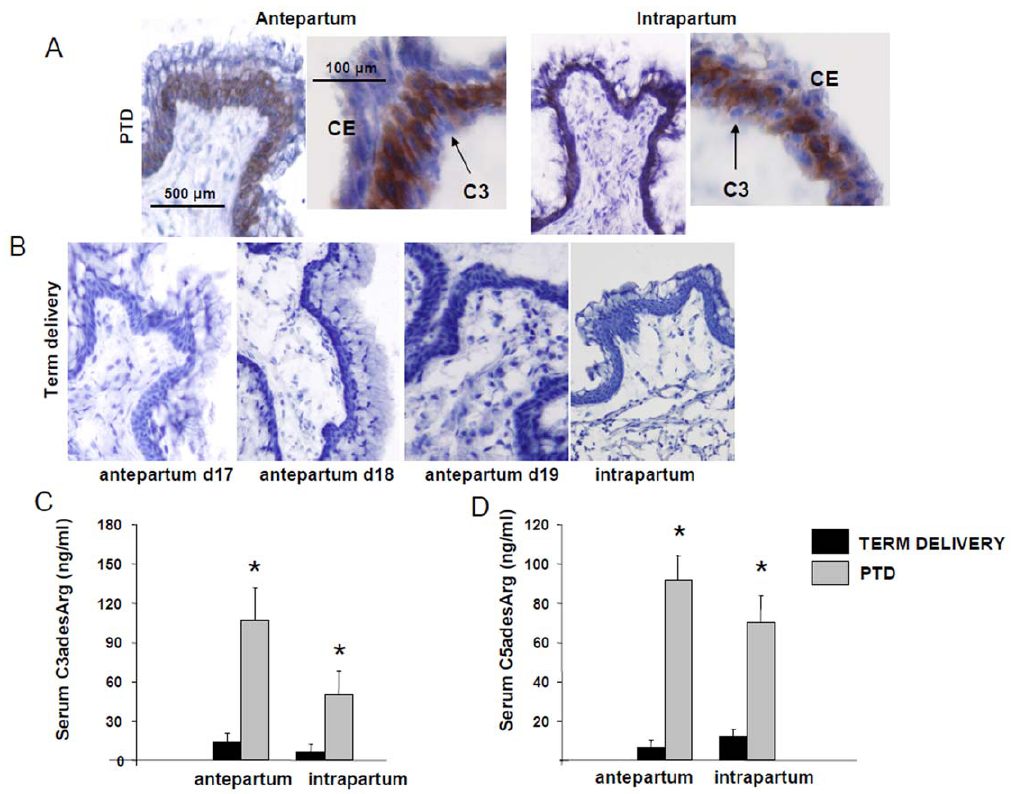
Figure 2. Complement activation in PTD and term delivery. A- Complement C3 deposition in the cervix of mice that delivered preterm antepartum and intrapartum. Black arrows point to complement deposition in the cervical columnar l epithelium (CE). Original magnification is 6 20. B- Complement C3 deposition in the cervix of mice that deliver at term. C3 deposition was not observed antepratum (days 17, 18 and 19) or intrapartum. Original magnification is 6 20. For C3 determination, 4 slides per animal were stained and 6–8 animals were studied in each group. C–D C3adesArg and C5adesArg levels in serum from mice with PTD and term delivery collected antepartum and intrapartum. Antepartum LPS serum samples were collected at day 15 of pregnancy, intrapartum LPS samples at days 16 and 17, antepartum term samples at days 17, 18 and 19 and intrapartum term at days 20 and 21. * Statistically different from control, p , 0.05. n=5–6 mice/group.